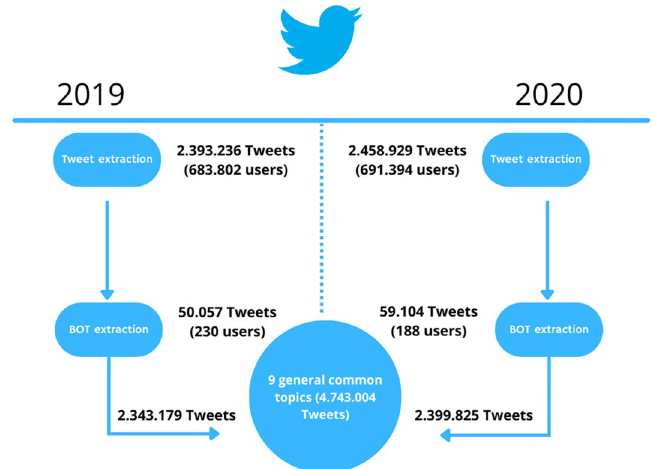
Fig. 2 Data flow overview of ASD Tweets in